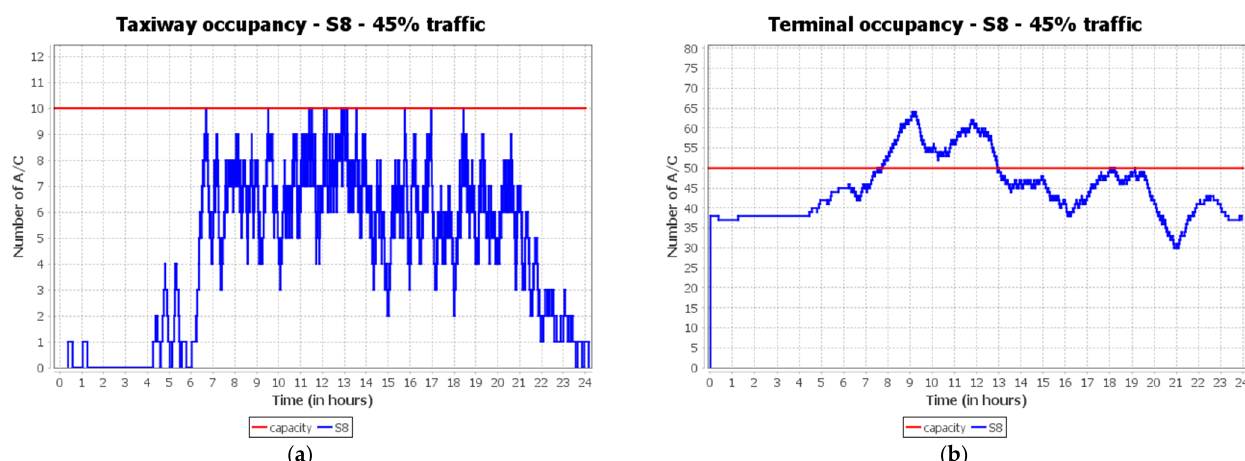
Figure 13. Taxiway ( a ) and Terminal ( b ) occupancy scenario S8.